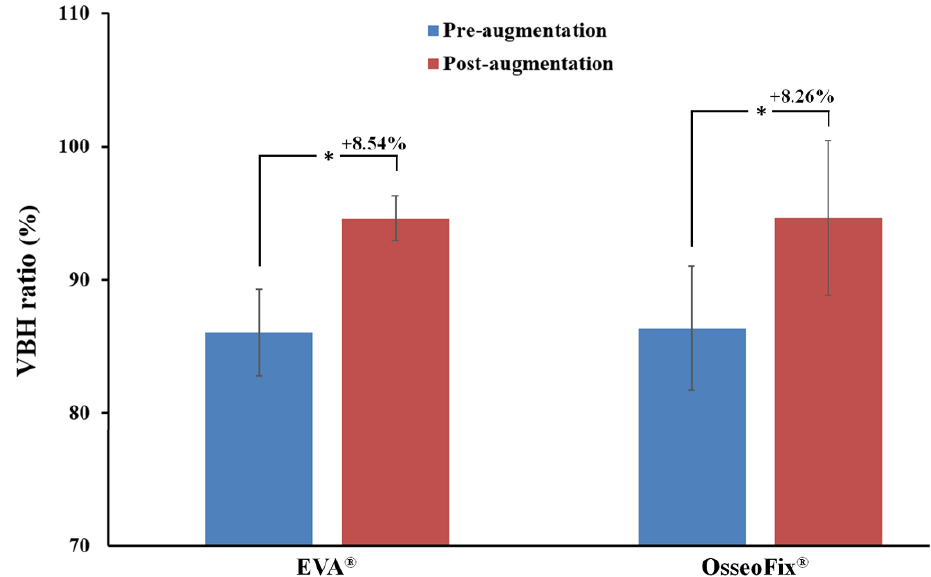
Figure 5. X-ray images showing vertebrae implanted with ( A ) EVA ® and ( B ) OsseoFix ® following bone cement injection. Top view ( upper ) and frontal view ( lower ).